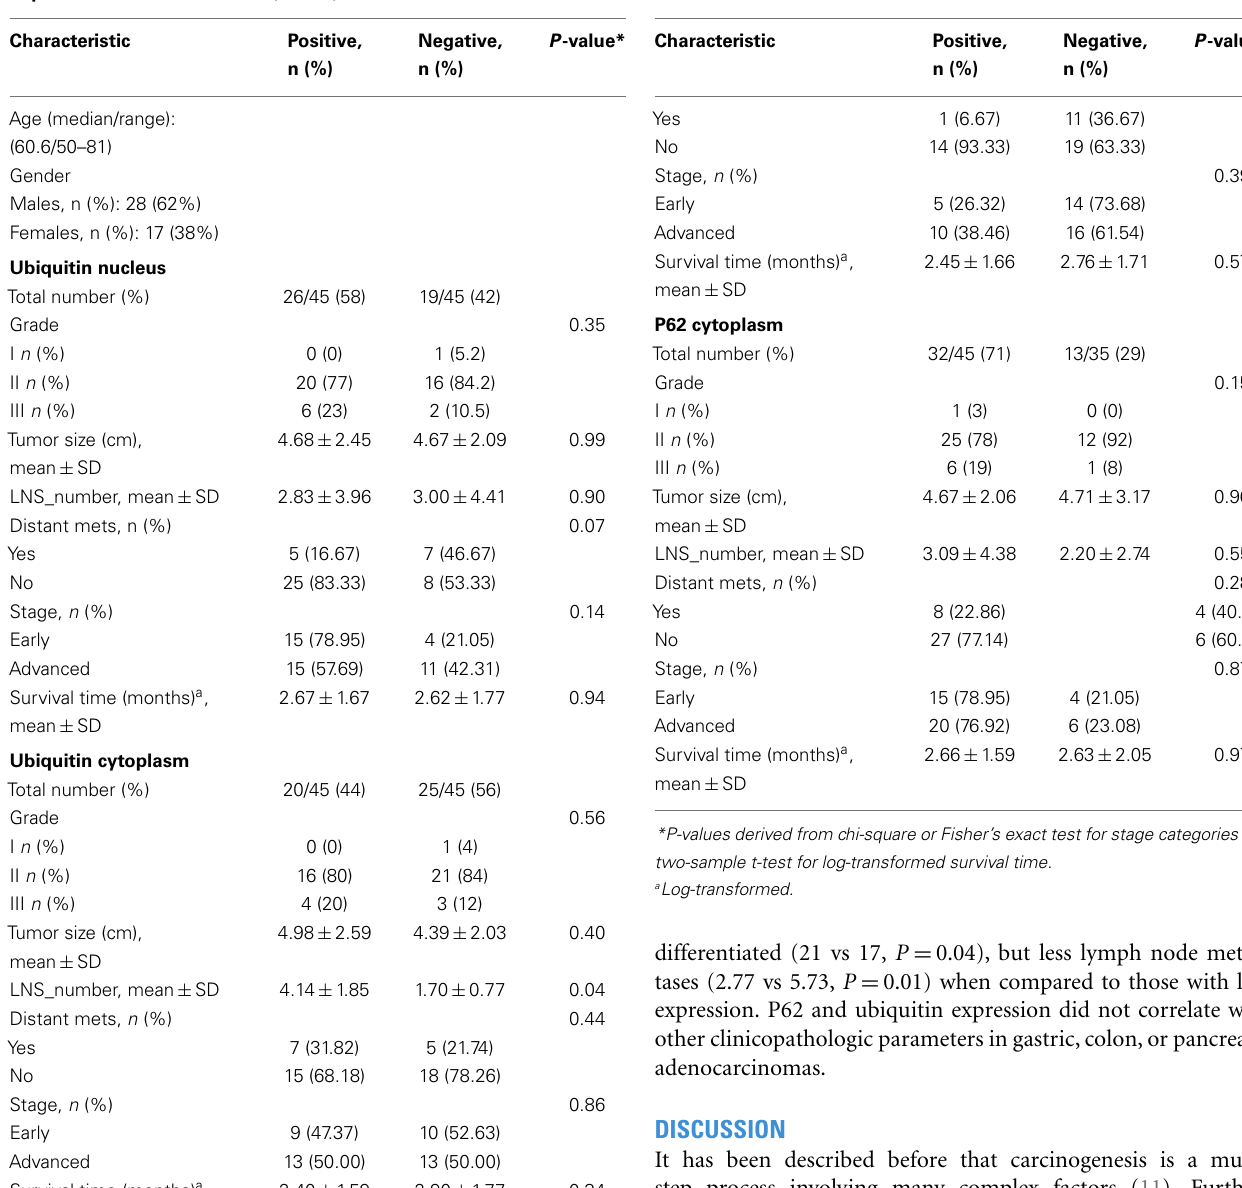
Table 2 | Multivariate analysis of tumor variables and overall survival in patients with colon cancer ( n = 45) .